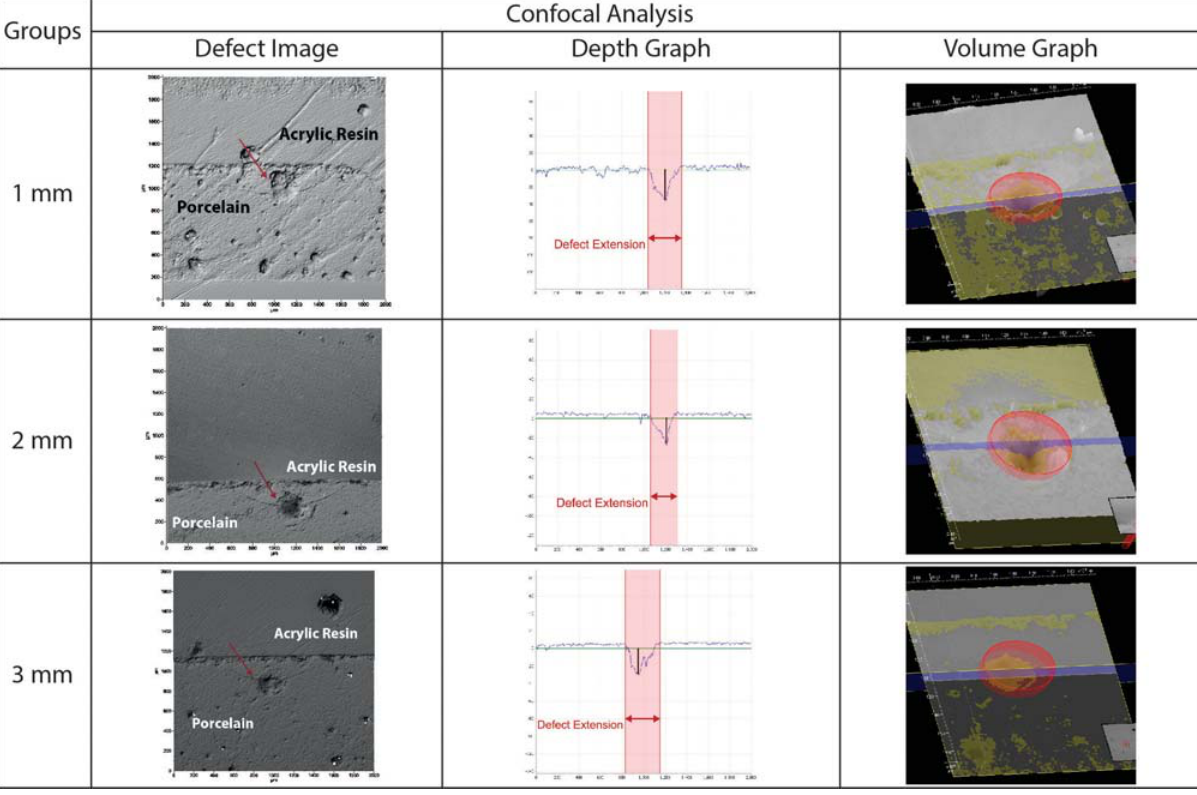
Figure 6- (cid:3)(cid:53)(cid:72)(cid:83)(cid:85)(cid:72)(cid:86)(cid:72)(cid:81)(cid:87)(cid:68)(cid:87)(cid:76)(cid:89)(cid:72)(cid:3)(cid:76)(cid:80)(cid:68)(cid:74)(cid:72)(cid:86)(cid:3)(cid:73)(cid:85)(cid:82)(cid:80)(cid:3)(cid:70)(cid:82)(cid:81)(cid:73)(cid:82)(cid:70)(cid:68)(cid:79)(cid:3)(cid:80)(cid:76)(cid:70)(cid:85)(cid:82)(cid:86)(cid:70)(cid:82)(cid:83)(cid:92)(cid:3)(cid:82)(cid:73)(cid:3)(cid:87)(cid:75)(cid:72)(cid:3)(cid:72)(cid:91)(cid:83)(cid:72)(cid:85)(cid:76)(cid:80)(cid:72)(cid:81)(cid:87)(cid:68)(cid:79)(cid:3)(cid:74)(cid:85)(cid:82)(cid:88)(cid:83)(cid:86)(cid:29)(cid:3)(cid:87)(cid:82)(cid:83)(cid:3)(cid:83)(cid:85)(cid:82)(cid:191)(cid:79)(cid:72)(cid:15)(cid:3)(cid:71)(cid:72)(cid:83)(cid:87)(cid:75)(cid:3)(cid:68)(cid:81)(cid:71)(cid:3)(cid:89)(cid:82)(cid:79)(cid:88)(cid:80)(cid:72)(cid:3)(cid:72)(cid:91)(cid:87)(cid:72)(cid:81)(cid:86)(cid:76)(cid:82)(cid:81)(cid:3)(cid:82)(cid:73)(cid:3)(cid:71)(cid:72)(cid:73)(cid:72)(cid:70)(cid:87)(cid:86)(cid:3) generated in the block specimens far from the